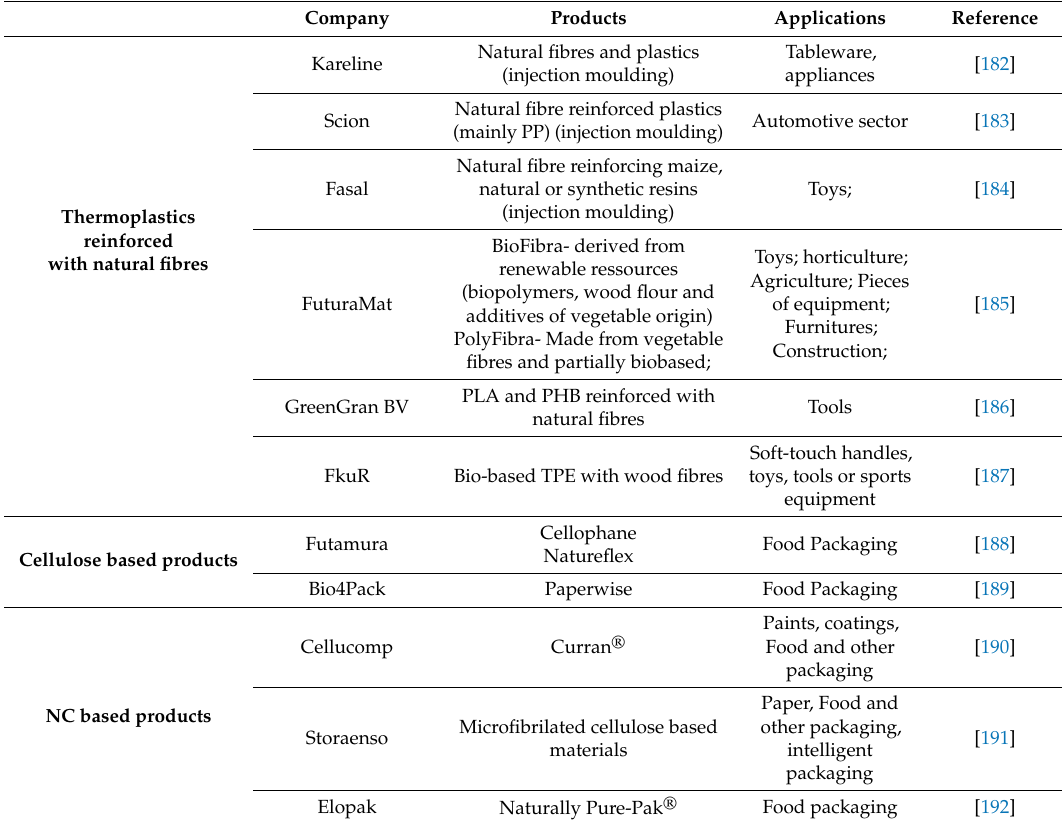
Table 3. Cellulose-based products in the market